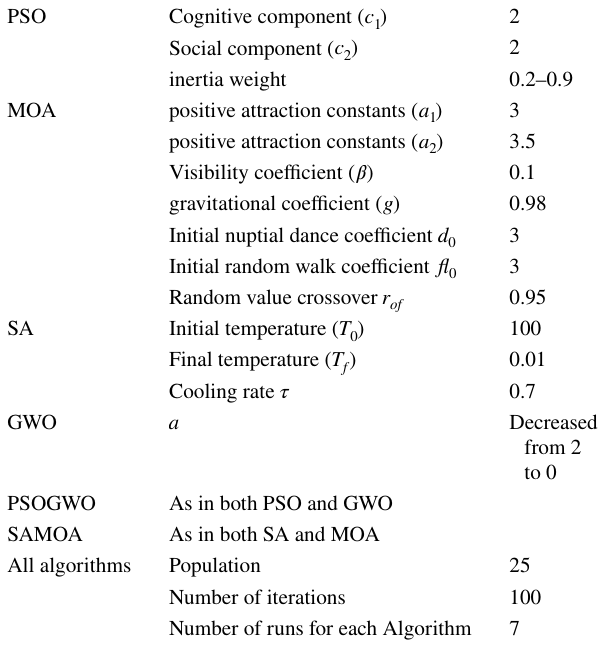
Table 1 Parameters setting of each optimization